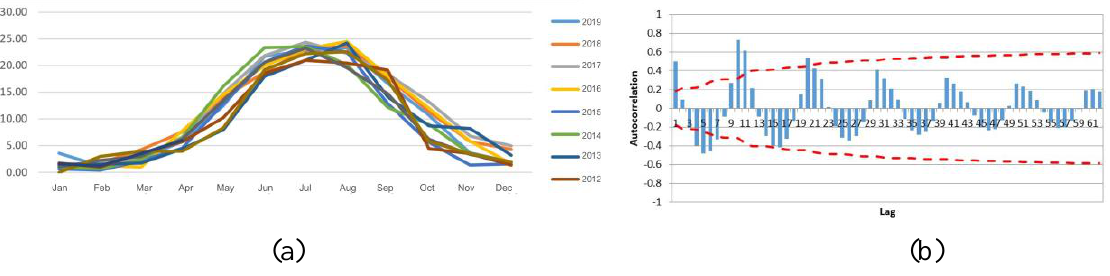
Figure 8. Water temperature: (a) Comparative distribution of water temperature during 2012-2019, (b) Autocorrelation function (with limited significance) for temperature in the range of 12 months